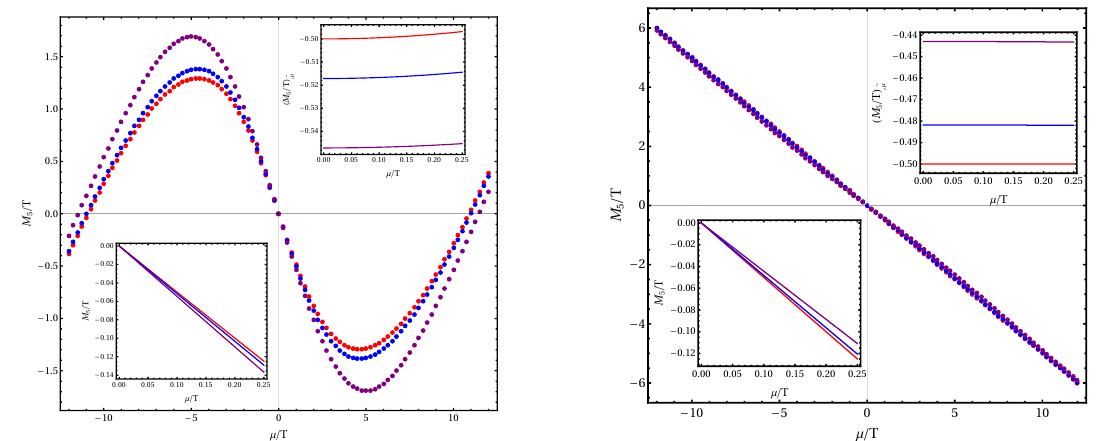
Figure 3 . The dimensionless magneto-vortical susceptibility M 5 /T as a function of the chemical √ potential µ/T for γ = 2 / 3 (left subfigure) and γ = 0 (right subfigure). The different curves correspond to magnetic fields B/T 2 = { 0 . 05 , 12 . 5 , 30 } (red, blue, purple).